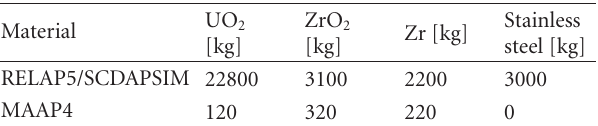
Table 3: Time of the core ba ffl e and the reactor vessel failure, Group